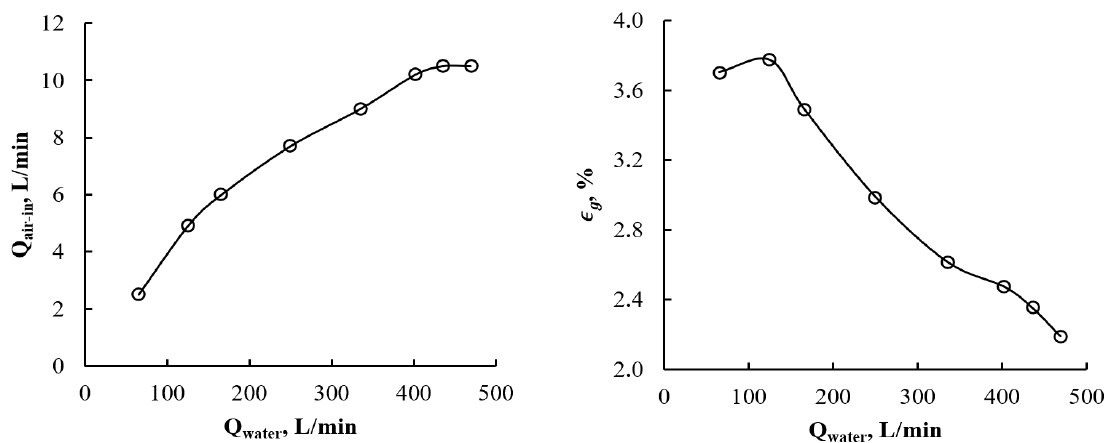
Figure 9. Aeration flow rate ( left ) and pipe cross-sectional void fraction ( right ) induced by the liquid stream at different water volumetric rates.